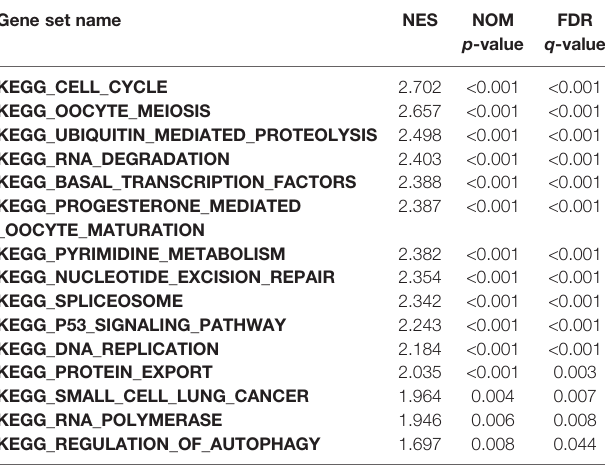
TABLE 6 | Gene sets enriched in the high HMMR expression